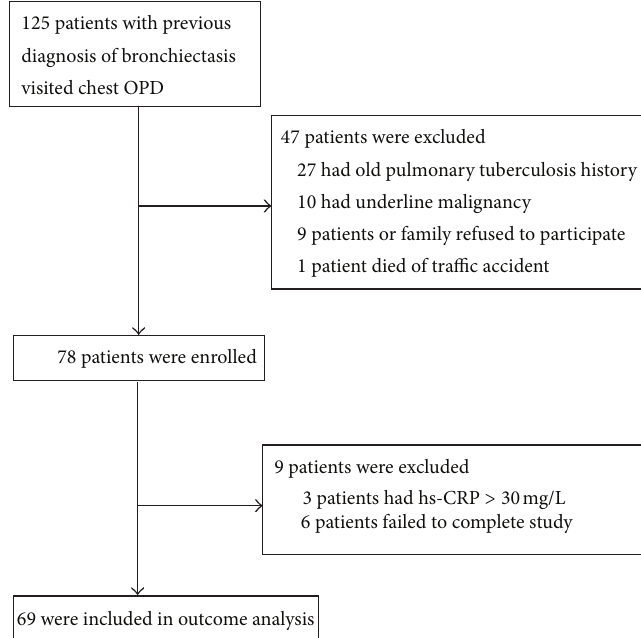
Figure 1: Flowchart of patients in the study cohort.